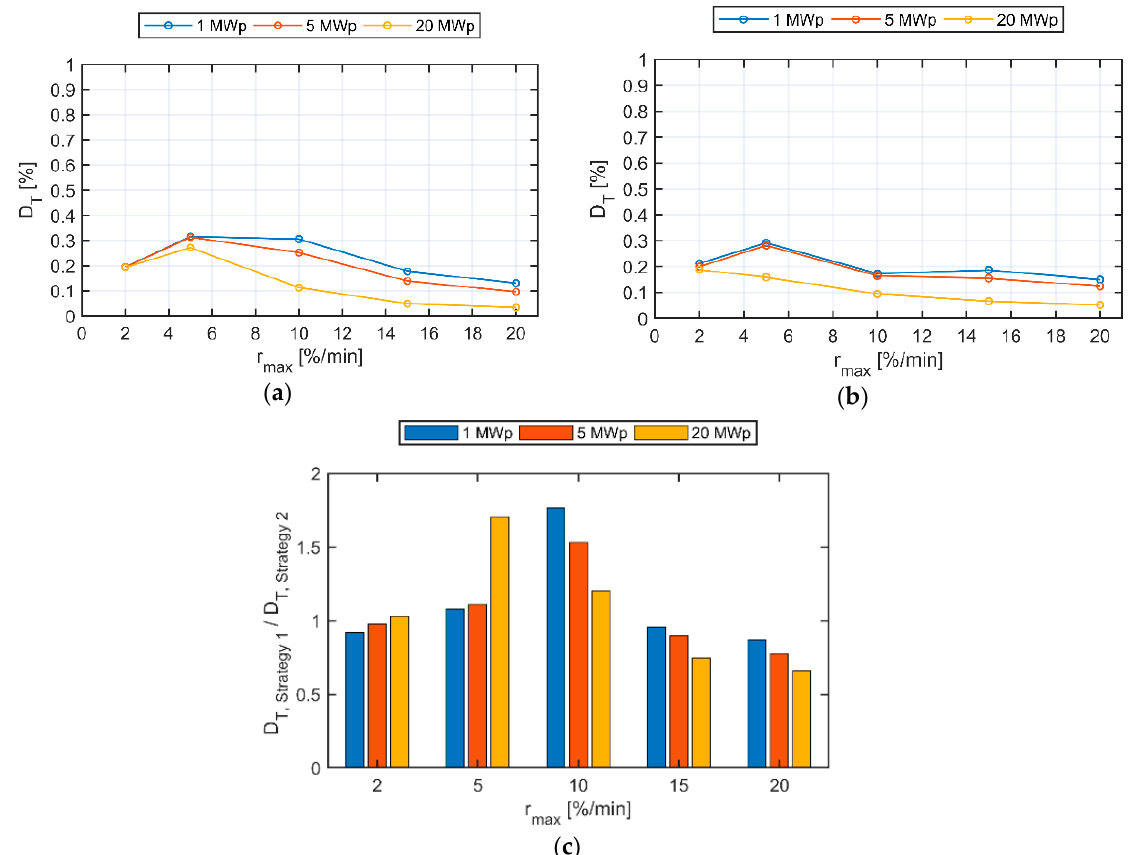
Figure 10. BESS degradation for the 288 days. ( a ) Strategy 1; ( b ) Strategy 2; and ( c ) Total degradation ratio between strategy 1 and 2.